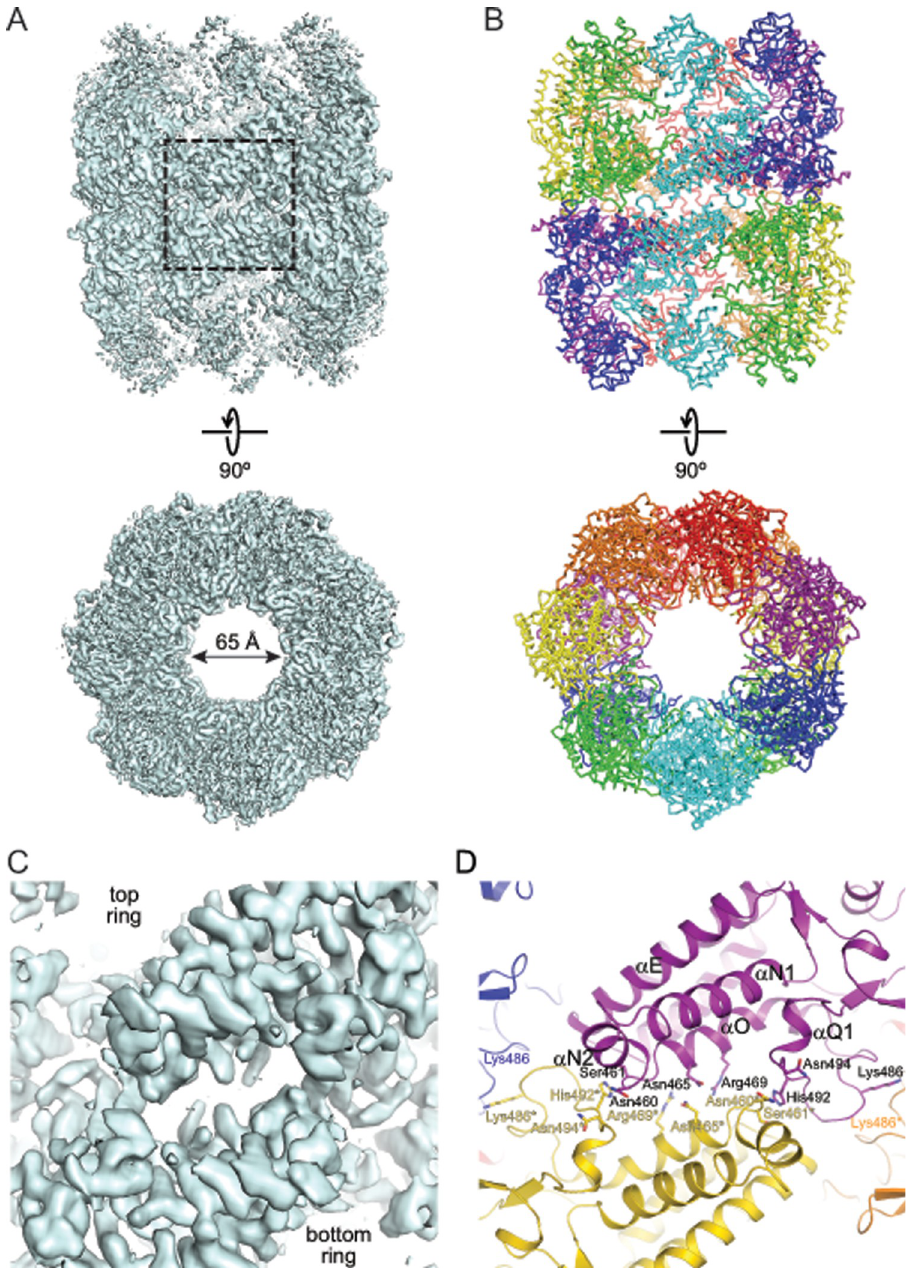
Fig 7. Cryo-EM structure of apo- ɸ EL. (A) Cryo-EM density map of apo- ɸ EL at 3.45 Å resolution. Perpendicular views of an isocontour surface at 4.8 σ is shown. The top view is along the two-fold symmetry axis. The box highlights the inter-subunit interface at the equator of the complex. (B) Atomic model of apo- ɸ EL. Backbone traces of the subunits are shown. Symmetry-equivalent subunits are shown in the same color. (C, D) Zoom on the symmetrical inter-subunit interface at the equator of the complex. Panel C shows the cryo-EM density. Panel D the model in ribbon representation. Contact sidechains are indicated and shown in stick representation (Glu466 is hidden behind the α O helix ribbon in this projection). Secondary structure elements participating in the interactions are